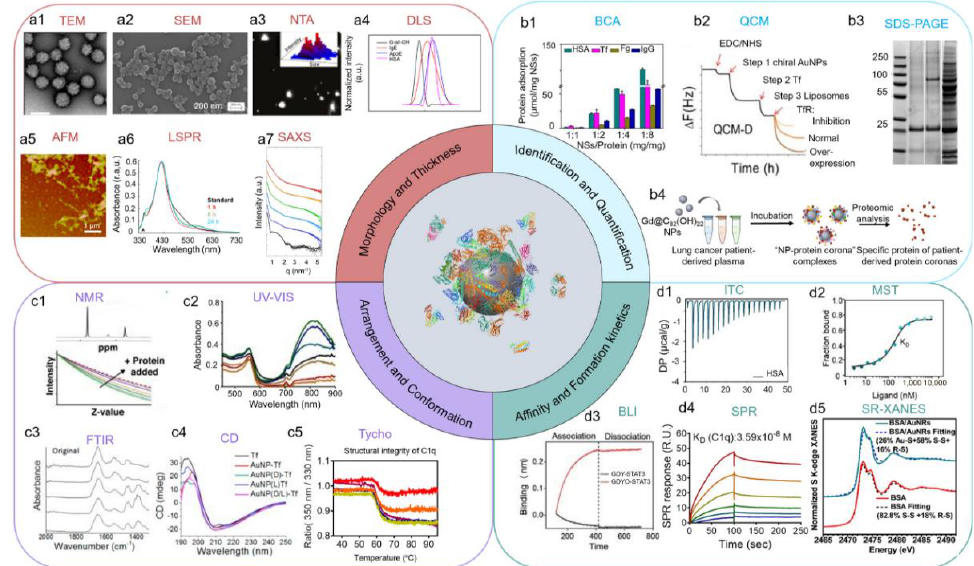
Figure 3. The research technologies used for the investigation of the protein corona are mainly divided into four parts: morphology and thickness; identification and quantification; arrangement and conformation; and affinity and formation kinetics [3]. Copyright 2022, American Chemical Society.